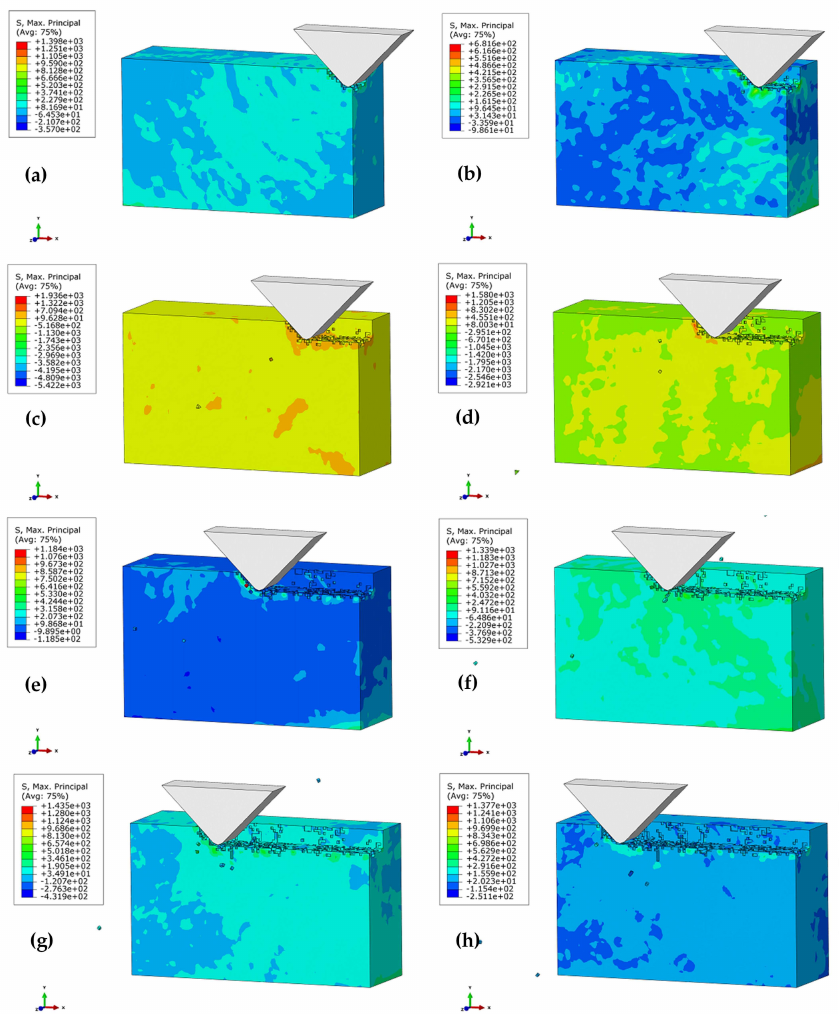
Figure 6. Brittle removal process of the silicon carbide polishing: ( a ) t = 2.63 × 10 − 6 s; ( b ) t = 5.25 × 10 − 6 s; ( c ) t = 7.88 × 10 − 6 s; ( d ) t = 1.04 × 10 − 5 s; ( e ) t = 1.31 × 10 − 5 s; ( f ) t = 1.58 × 10 − 5 s; ( g ) t = 1.86 × 10 − 5 s; ( h ) t = 2.13 × 10 − 5